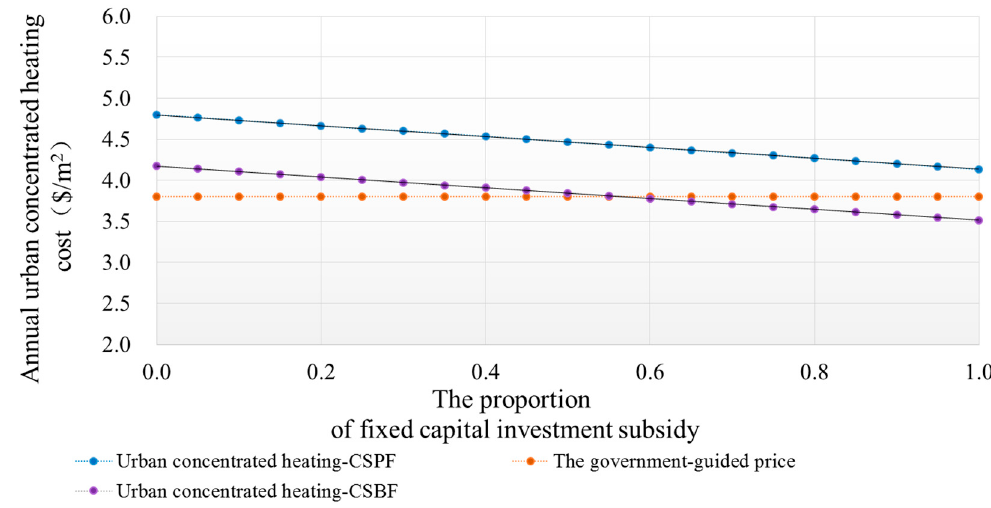
Figure 4. Influence of fixed capital investment subsidy on the economic performance of CSDF for urban concentrated heating.